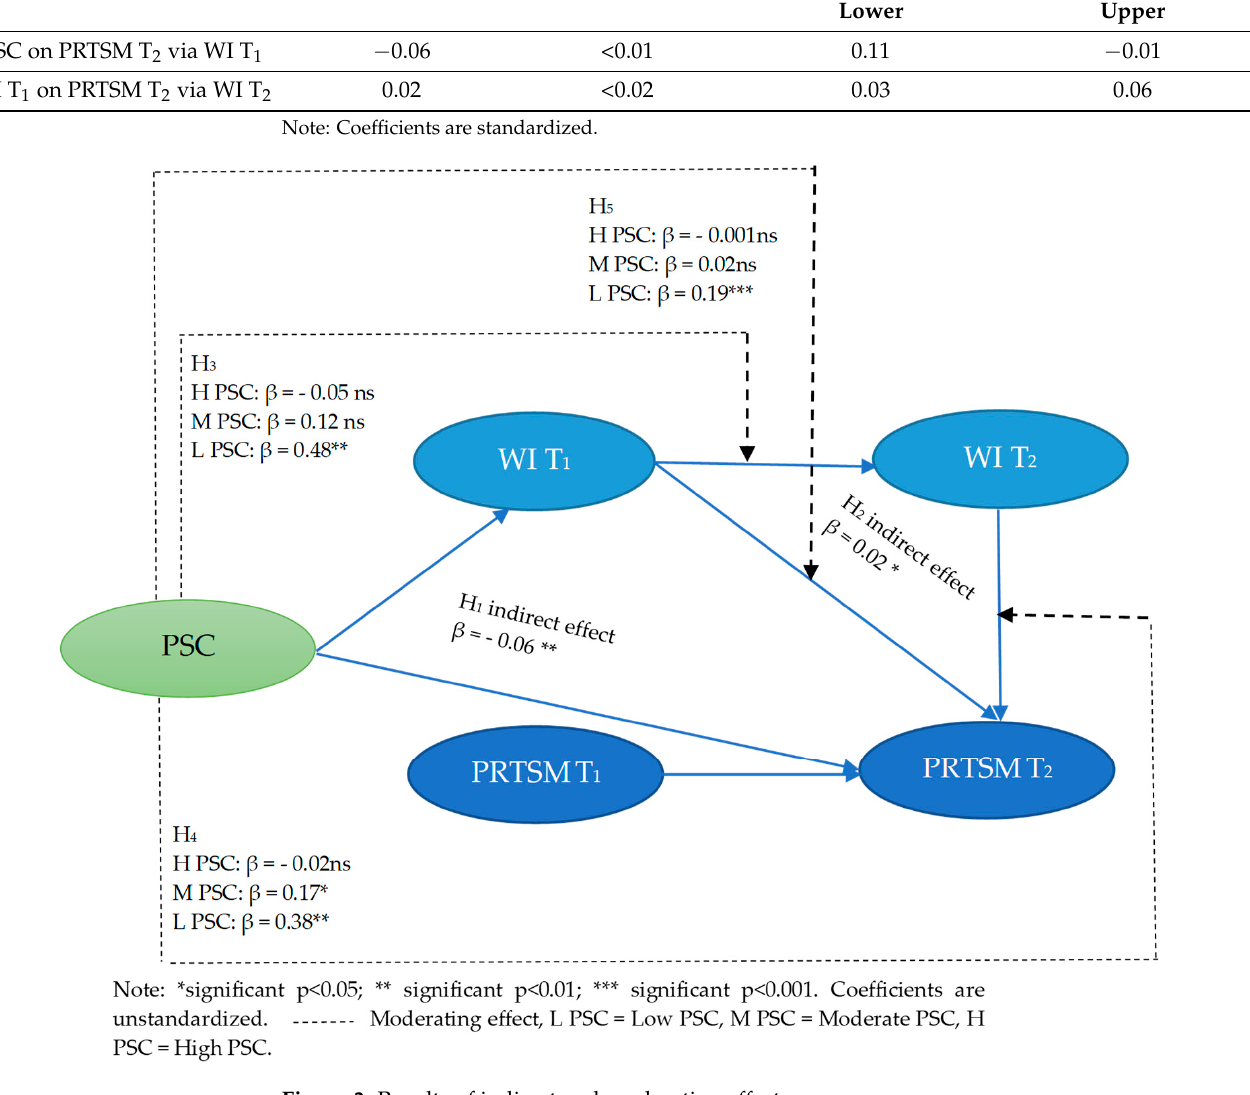
12 of 19 Table 5. Multi-group analysis of PSC: Conditional indirect effect of WI T 1 on PRTSM T 1 through WI T 2 (X on Y through M, H5).